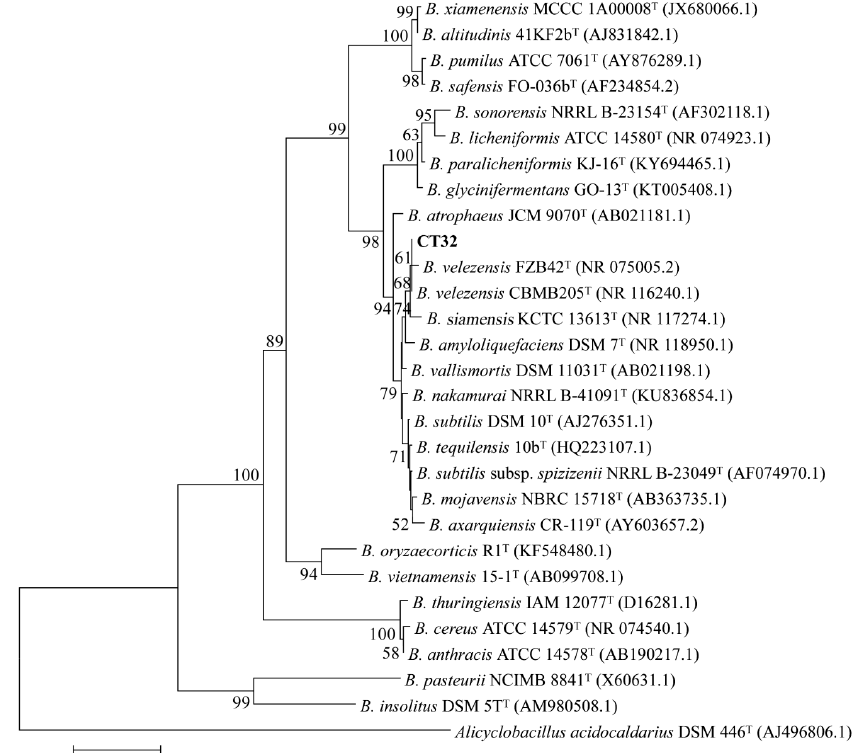
Figure 5. Neighbor-joining (NJ) tree based on 16S rRNA gene sequences, highlighting the phylogenetic relationship of strain CT32 to other strain types of the genus Bacillus . Bootstrap values (1000 replications) greater than 50% are given at branch points. Scale bar = 0.02 substitutions per nucleotide position.